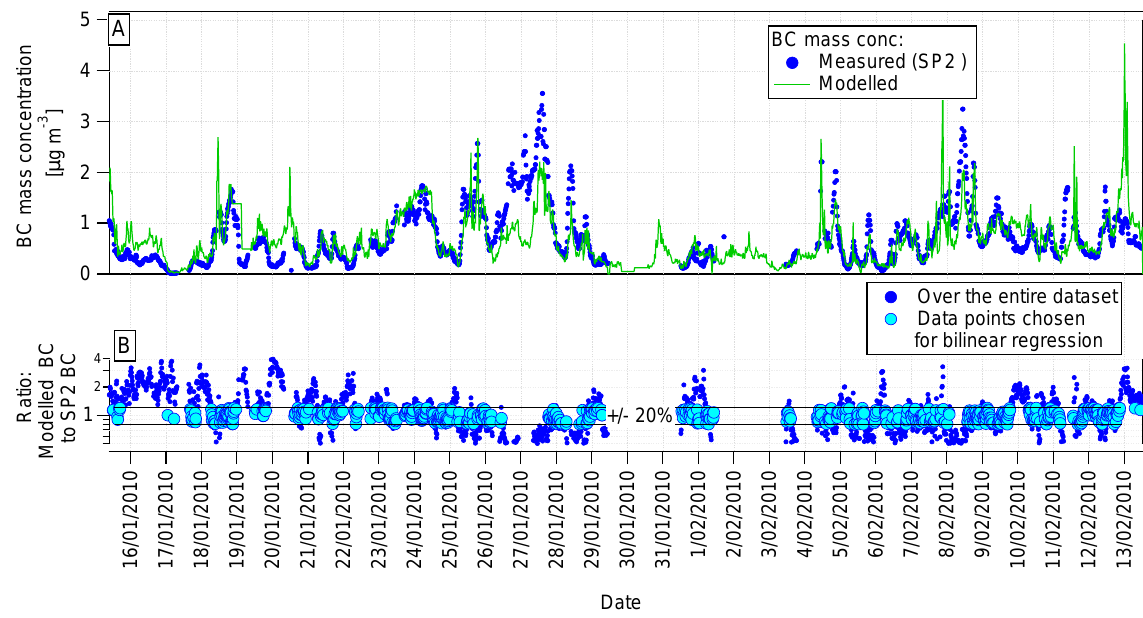
Fig. 8. (A) BC mass concentration, as measured by the SP2 and modelled with a bilinear regression. (B) Relative difference between modelled and measured BC mass concentrations. Only those data points for which the modelled BC mass concentration agreed within ± 20% with the measured BC mass concentration were considered for the bilinear